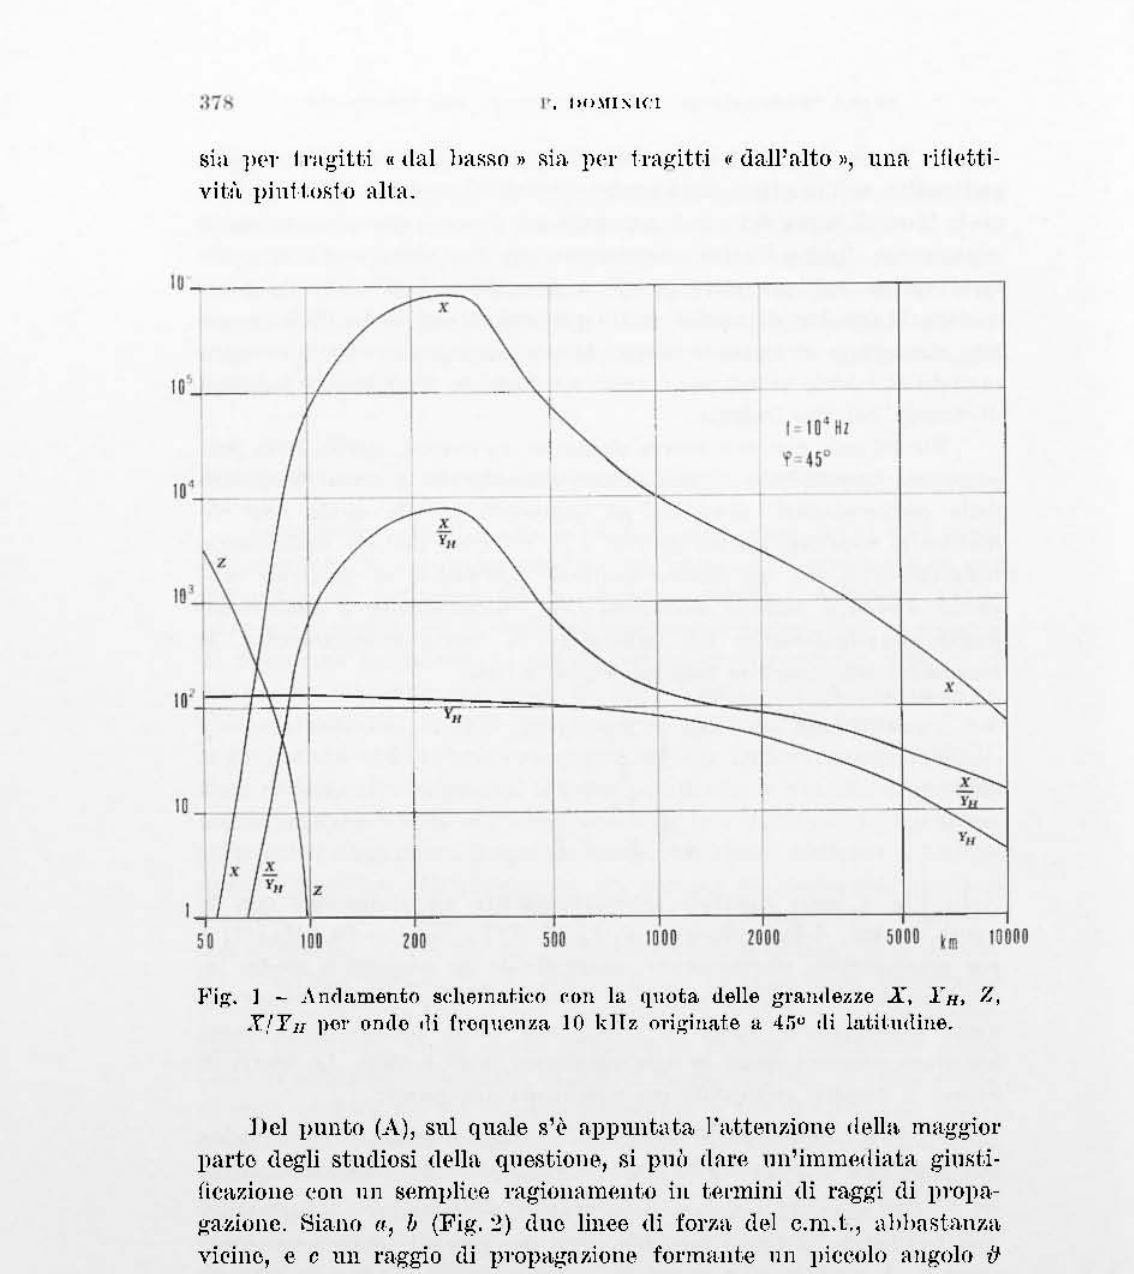
]leI punto (A), sul quale s'è appuntnta l'attenzione della maggior parte degli studiosi della questione, si può dal'P uu'immpdiata gillli1,i ficallÌone ('on 1111 spmpliep ragionamml1,o in t.m'mini di raggi di propa· gazione. Siano 11, b (Fig,:!) due linee di forza del c.m. L, nhha~ta.Jlza vicine, e c un raggio di propagazione formaut.e 1111 lliceolo angolo {j ('O)) la linea a. Tndieaudo eon O. la e11l'Vatura loca.\e del raggio c,